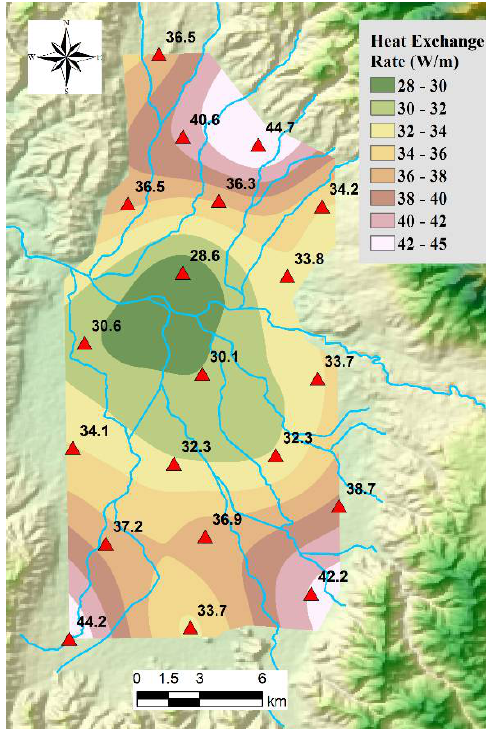
Figure 7. Distribution map of heat exchange rates.